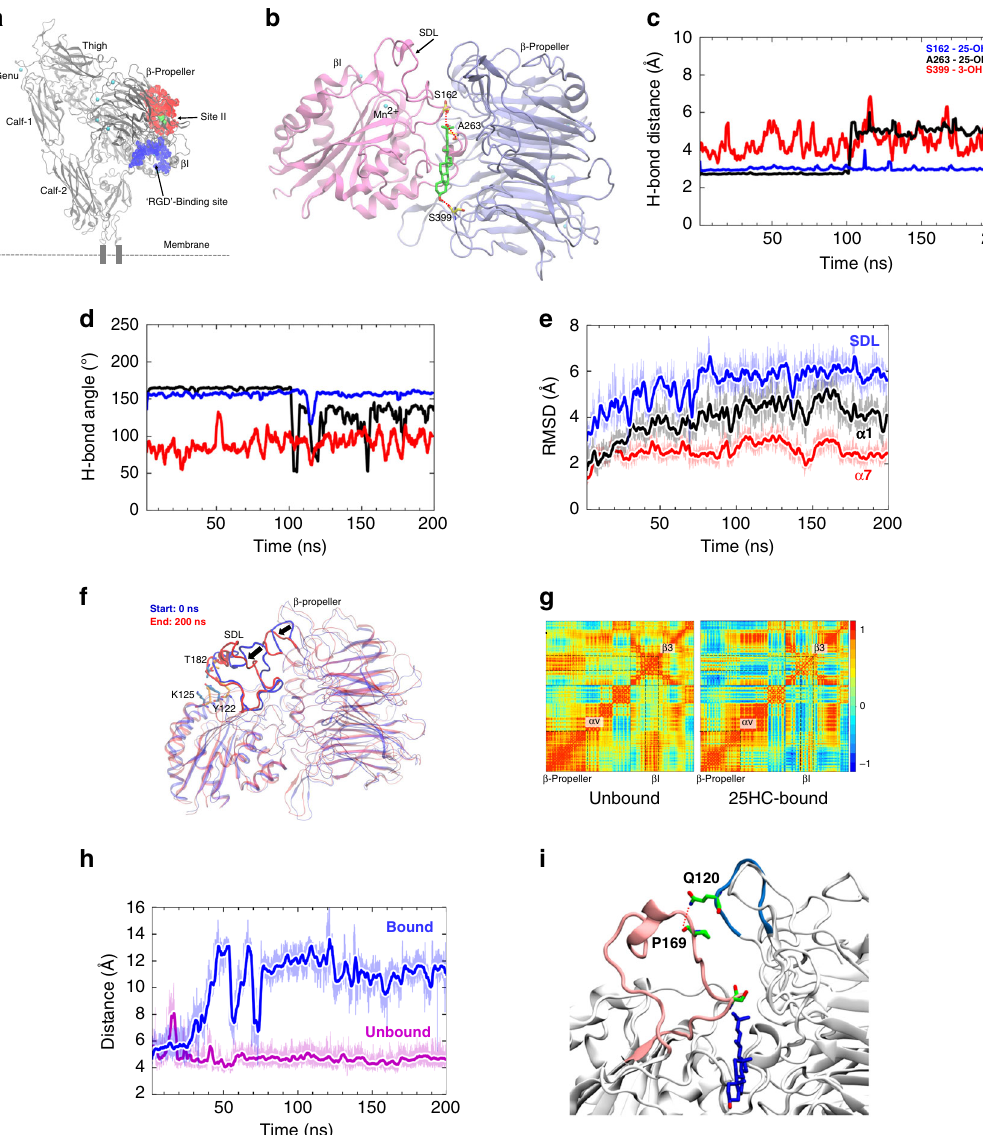
Fig. 3 Modeling identi fi es speci fi c interactions between α v β 3 integrin and 25HC. a Ectodomain structure of α v β 3 integrin containing ‘ RGD ’’ -binding site (site I) (blue) and site-II (red) residues highlighted by a layer of solvent molecule of radius 1.4 Å. The site-II-bound 25HC molecule is presented as a surface model in green and Mn 2 + ions from metal-ion-dependent ligand-binding site (MIDAS) and adjacent to MIDAS (ADMIDAS) sites of β I domain, β -propeller domain and genu knee region are presented in cyan. b Potential interacting residues for molecular recognition of α v β 3 integrin by 25HC were identi fi ed in a docking simulation. H-bonds are highlighted in dashed lines in red. c , d Ser399 of β -propeller (red), Ser162 (blue) and Ala263 (black) of β I domain make stable H-bond interactions with 3- and 25-hydroxyl groups of 25HC, respectively. The H-bond distances ( c ) and H-bond angles ( d ) are plotted against MD simulation time (200 ns). e The root-mean-square deviations (RMSD) measured for speci fi city-determining loop (SDL), α 1- and α 7 helices during the entire 200 ns long simulation. The SDL region undergoes signi fi cant conformational change (RMSD of ~6 Å) upon 25HC binding. f The conformational change in the SDL is accompanied by disruption of H-bond interaction between Tyr122-Thr182 residues, as well as change in the β -propeller blade that interacts with SDL. Movement of the regions from the beginning 0 ns (blue) to the end 200 ns (red) is indicated by arrows. g Correlation matrices (as heat maps) indicating correlated (red) or anti-correlated motions (blue) of α - and β -subunits of α v β 3 integrin in unbound and 25HC-bound states. h , i The distance between the amide NH of Q120 of the β -propeller domain and backbone carbonyl oxygen of P169 of the SDL. Breakage of this electrostatic interaction in the 25HC-bound protein (blue) during the simulation, around ~30 ns simulation causes signi fi cant increase in the distance, which remain intact in the unbound protein (magenta) during the entire 200 ns simulation